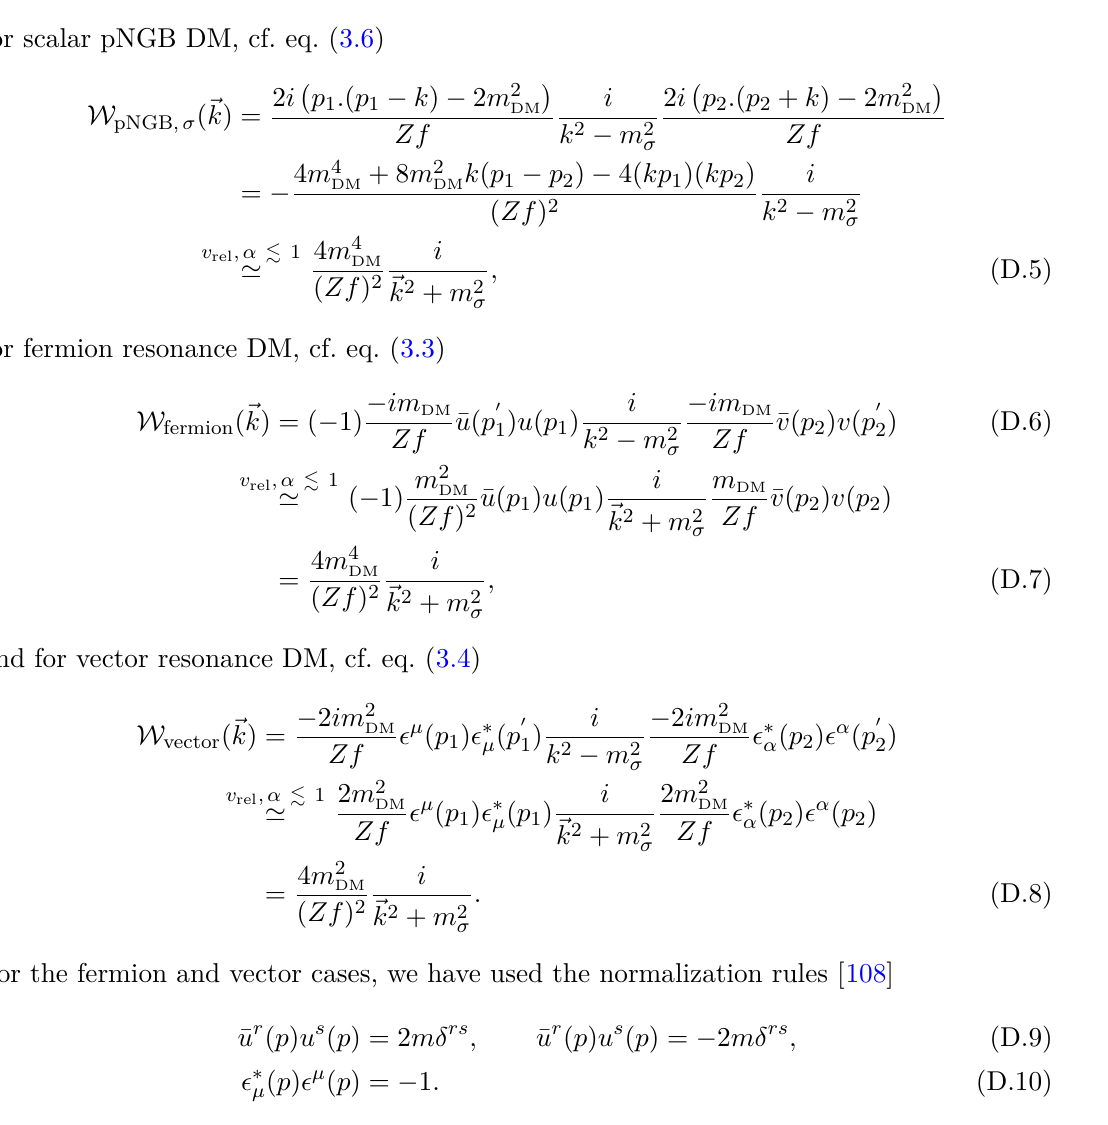
Figure 17 . Feynman diagram of the 4-point function amplitude W ( ~k ) , either dilaton σ or Higgs h mediated, for pNGB DM η . Generalization to scalar, fermion and vector resonance DM is straight-